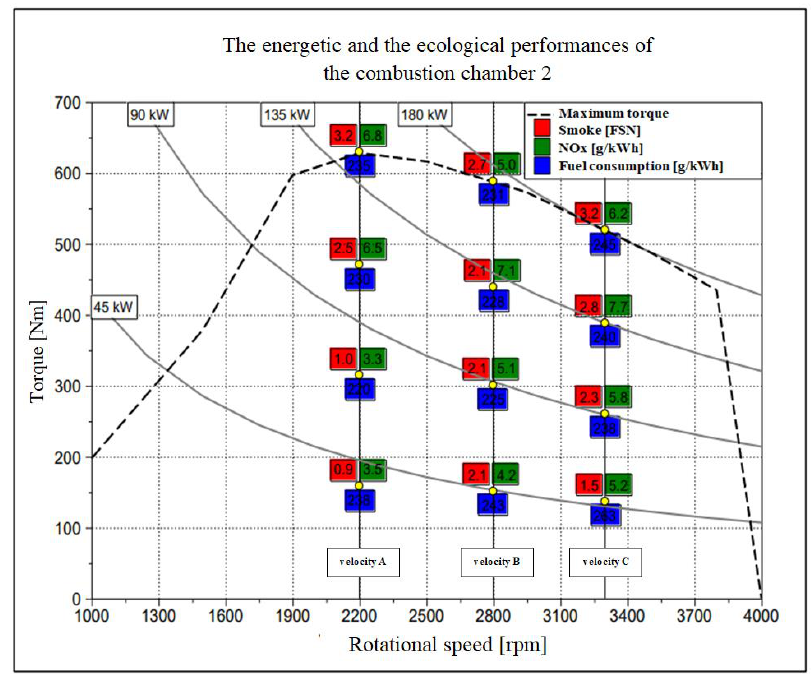
Figure 30. The energetic and the ecological parameters of the engine equipped with the combustion chamber 2 (butterfly shape).